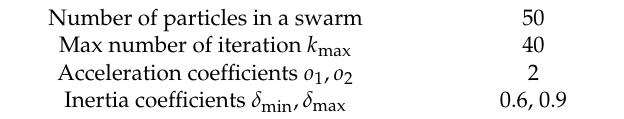
Figure 7. Flowchart of PSO mechanism. Table 2. Main parameters of PSO Algorithm.